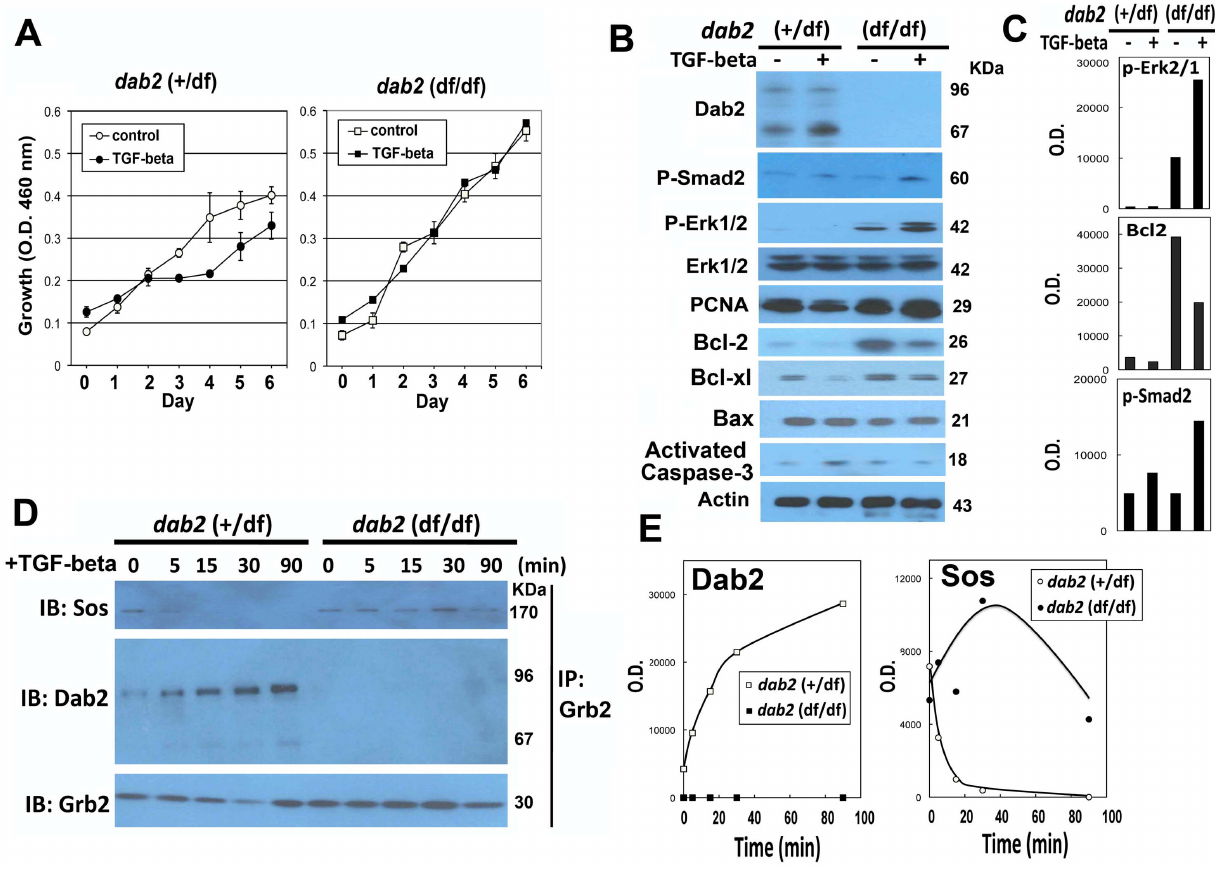
Figure 7. Dab2 modulates TGF-beta-stimulated growth regulation and signaling in primary mammary epithelial cells. Mammary epithelial cells were prepared from pregnant control ( + /df) and dab2 conditional knockout (df/df) mice inheriting Sox2-Cre. The cells were treated with or without TGF-beta (10 ng/ml). ( A ) Growth of the cells was determined by WST assay over a 6-day period. Student-t test indicated that the difference in cell growth was statistically significant for at day 3 to 6 for dab2 ( + /df) (p , 0.005) but not dab2 (df/df) cells. ( B ) Protein lysates prepared from the primary cultures were analyzed by Western blots for Dab2, phospho-Smad2, E-cadherin, N-cadherin, phospho-Erk1/2, total Erk1/2, PCNA, Bcl-2, Bcl-xl, Bax, activated caspase-3, and beta-actin. ( C ) The relative protein level was quantified from the Western blots using NIH Image J software, and the values of the optical density (O.D.) critical markers (p-Smad2, p=Erk1/2, and Bcl-2) were compared. ( D ) Co-immunoprecipitation was performed to determine the association between Grb2 and Sos or Dab2. The primary cells were stimulated by TGF-beta for a time course of 0, 5, 15, 30, and 90 min. At each time point, the monolayer was washed with ice-cold PBS, lysed, and the post-nuclear supernatants were used for immunoprecipitation with antibodies against Grb2. The eluted proteins from the immunoprecipitation were separated by SDS-PAGE, and immunoprobed for Sos, Dab2, and Grb2. The immunoprecipitation experiments were performed twice and similar results were obtained. ( E ) Relative Dab2 and Sos protein amounts in the Western blot were estimated using NIH Image J program and the O.D. values were